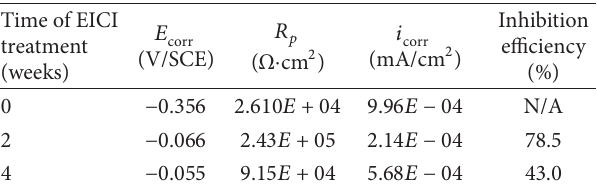
Table 6: 𝐸 corr , 𝑅 𝑝 , and 𝐼 corr values obtained from the weak polariza- tion tests for contaminated samples (0.5% chloride) with or without EICI treatment in sodium borate